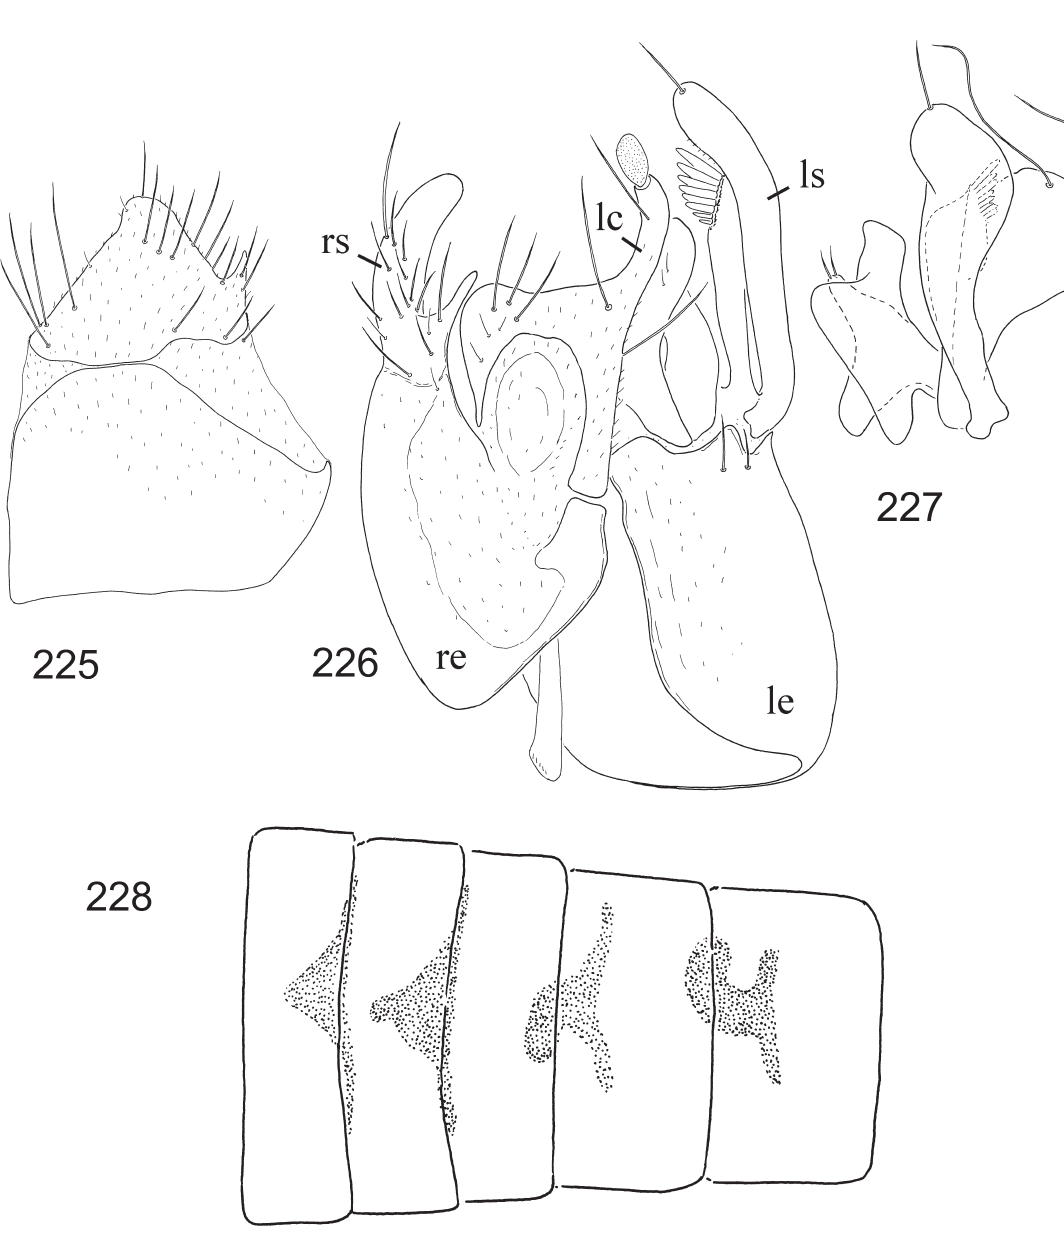
Figs 225-228. Stilpon nigripennis sp. nov., ♂. 225 . right epandrial lamella. 226 . epandrium with cerci. 227 . left surstylus. 228 . gland-like structures (dark stiple) on abdomen, dorsal